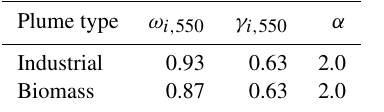
Table 2. Optical properties as a function of plume type. Here, ω i denotes the mid-visible (550nm) single-scattering albedo, γ i the asymmetry parameter (also at 550nm) and α the Ångström coef- ficient in Eq.